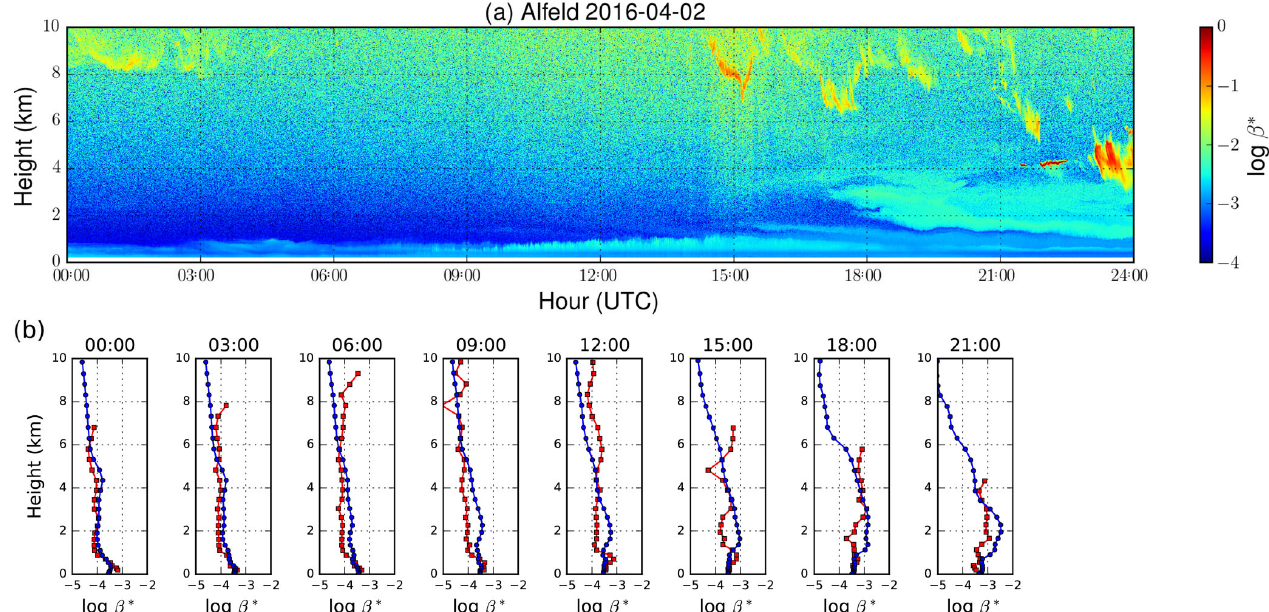
Figure A1. Time series of attenuated backscatter measured by the ceilometer (a) and simulated by the model (b) in Alfeld during a dust episode on 2 April